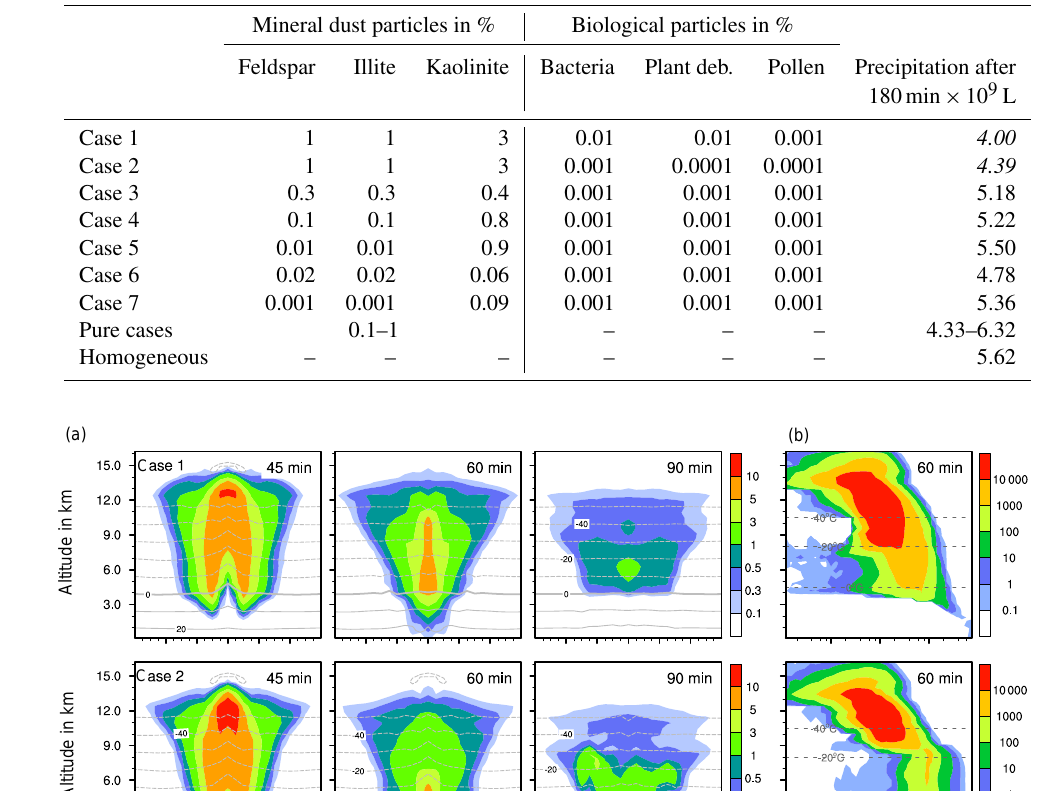
Table 4. Total precipitation after 180min of modeling time for coupled homogeneous and internally mixed immersion freezing. Marked in italics: cases with more than 20% reduction of precipitation.